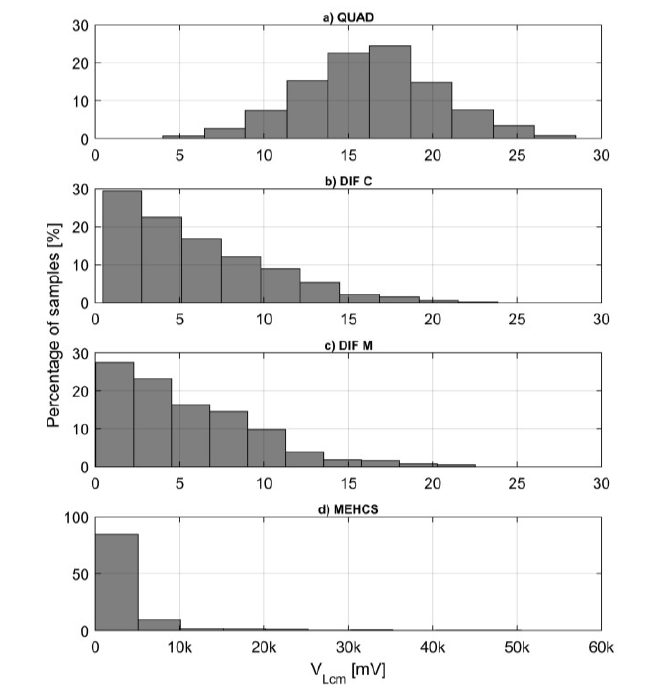
Fig. 22: Common mode voltage distribution using Monte Carlo simulation considering resistors with 1% tolerance.